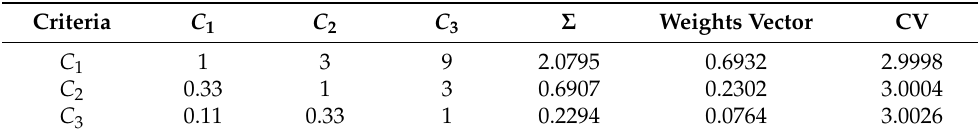
Table 6. Normalized pair-wise comparison matrix, weights, and consistency vector.